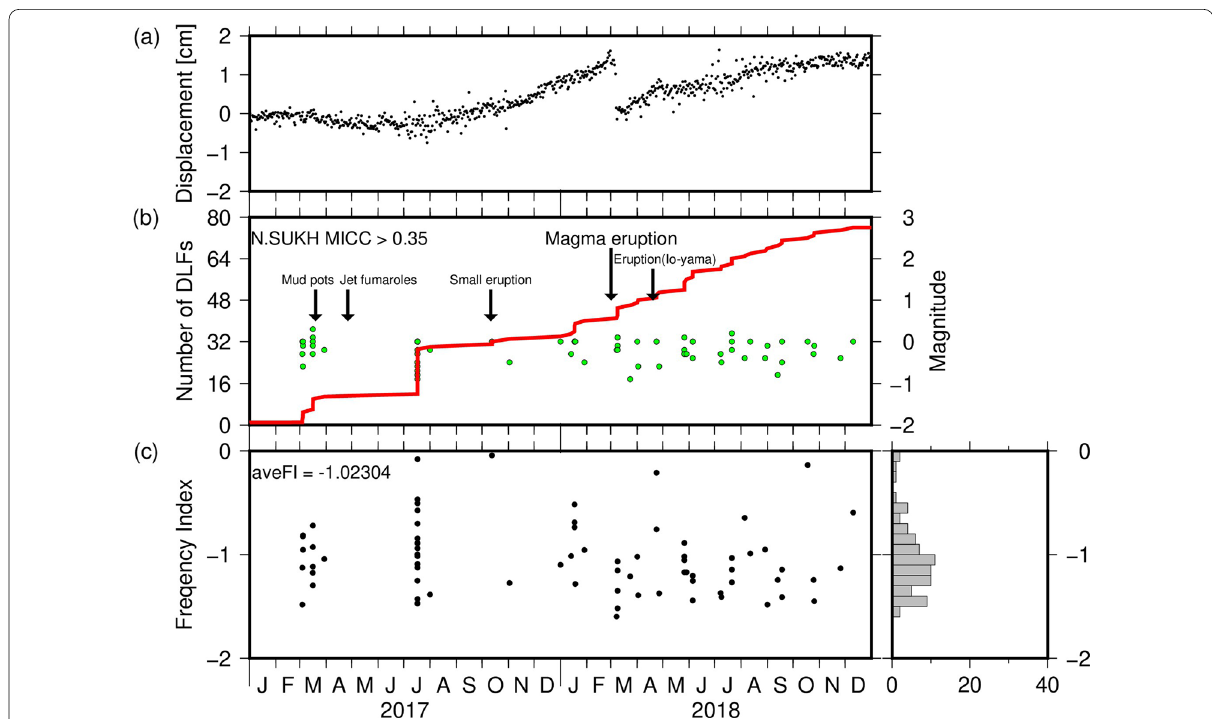
Fig. 2 Geodetic and DLF earthquake observations in the Kirishima volcanic complex during the 2017–2018 period. a Horizontal displacement at Ebino GNSS station relative to Makizono (see Fig. 1). We use the F3 solutions provided by the Geospatial Information Authority of Japan. b Cumulative number of DLF earthquakes (red line) and DLF earthquake magnitudes (green circles). The DLF earthquakes were selected after visual inspection. Arrows mark the timings of appearances of mud pots and jet fumaroles (Tajima et al. 2020), as well as the eruptions. c Frequency index (FI) of the DLF earthquakes. The right panel shows the FI frequency